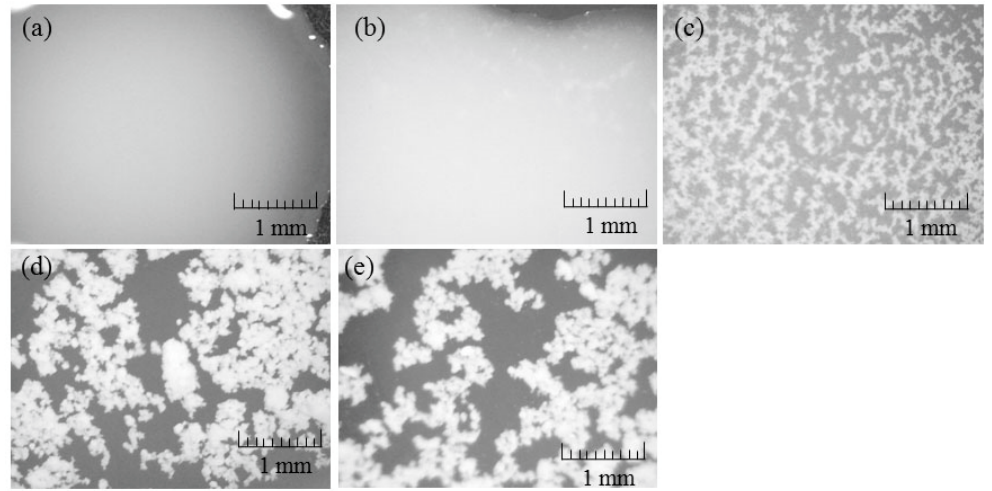
Figure 9. Charge coupled device images of ( a ) NR latex; and ( b – e ) self-assembled CNF-NR dispersions (CNF:NR (weight ratio) = 0.01, 0.02, 0.1, 0.2:1, respectively) after evaporation of ammonia.